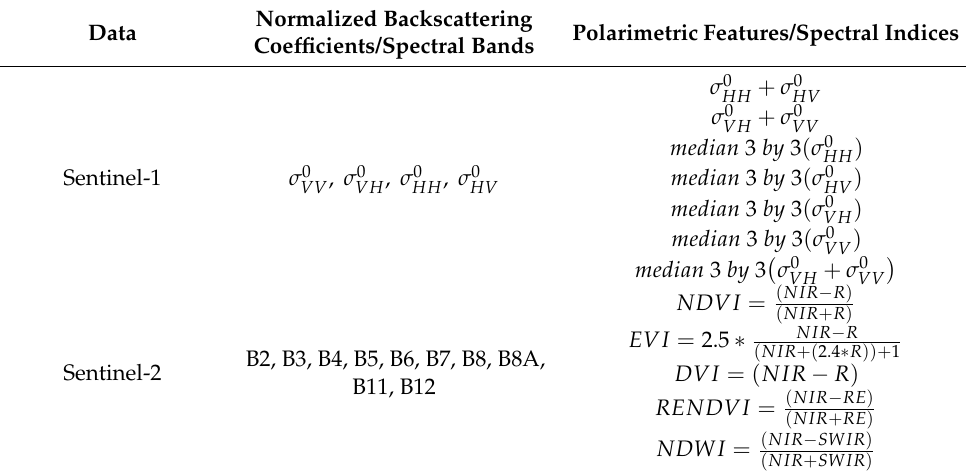
Table 2. Spectral bands, indices, the normalized backscattering coefficients, and polarimetric features extracted from optical and SAR imagery utilized in this research (NDVI: Normalized Difference Vegetation Index, EVI: Enhanced Vegetation Index, DVI: Difference Vegetation Index [42], RENDVI: Red Edge Normalized Difference Vegetation Index, NDWI: Normalized Difference Water